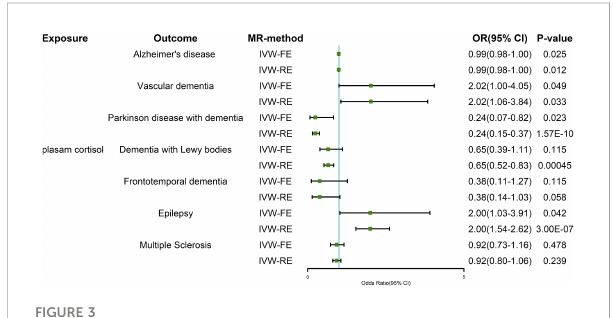
FIGURE 3 Two-sample Mendelian randomization estimates of the relationship between plasma cortisol and outcomes using IVW-FE and IVW-RE methods. IVW-FE, inverse variance weighted freedom-effects; IVW- RE, inverse variance weighted random-effects; OR, odds ratio; CI, con fi dence interval.